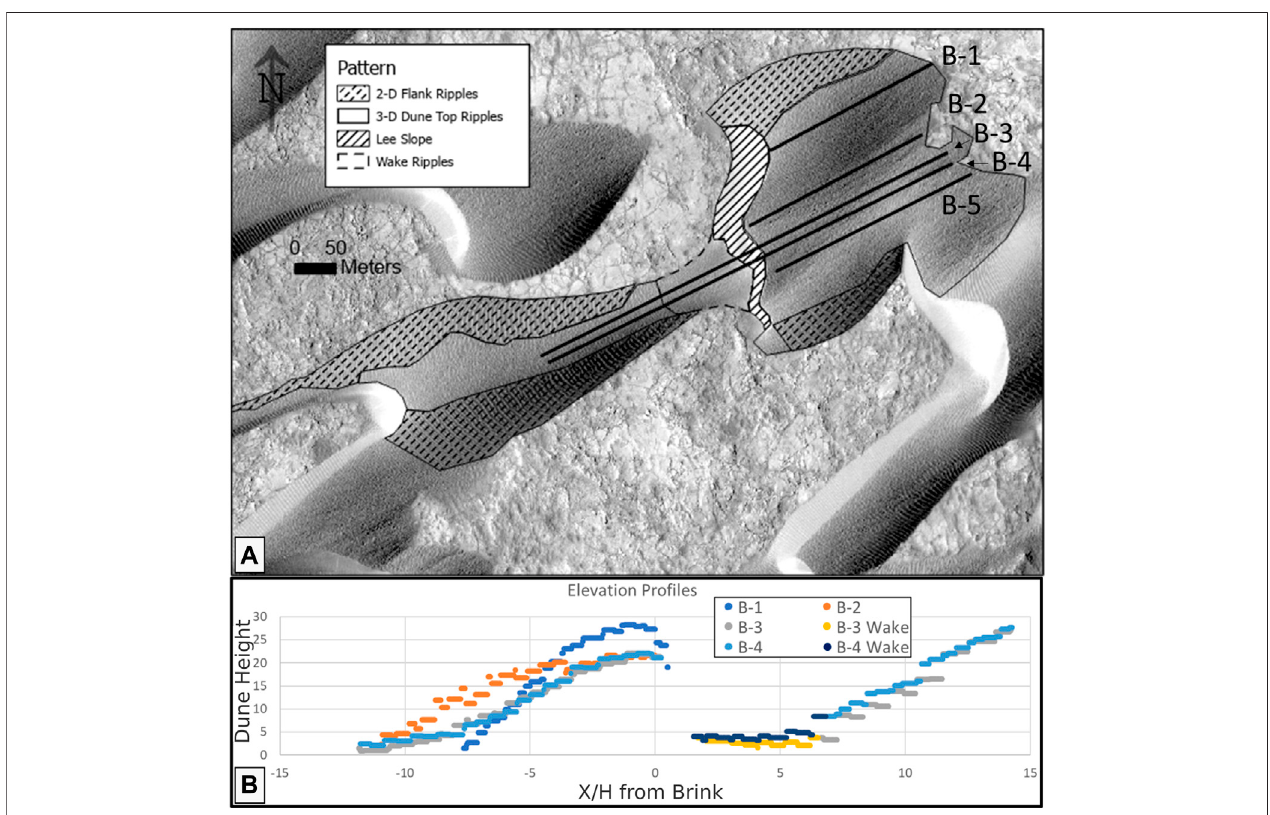
FIGURE5| ImageofDuneBwithripplesandtransectsmapped.Elevationalongeachtransectisshowninthelowerrightcorner,withleeslopesremovedforclarity and areas mappedas “ Wake Ripples ” highlightedinthepro fi le.The distance fromthebrinkismeasured positiveinthedownwinddirection. Forclarity,thepro fi le forB-5 is not included as it is nearly identical to the pro fi les for B-3 and B-4. Artifacts in the elevation data are due to the spline fi t used to model the sub-dune bedrock.